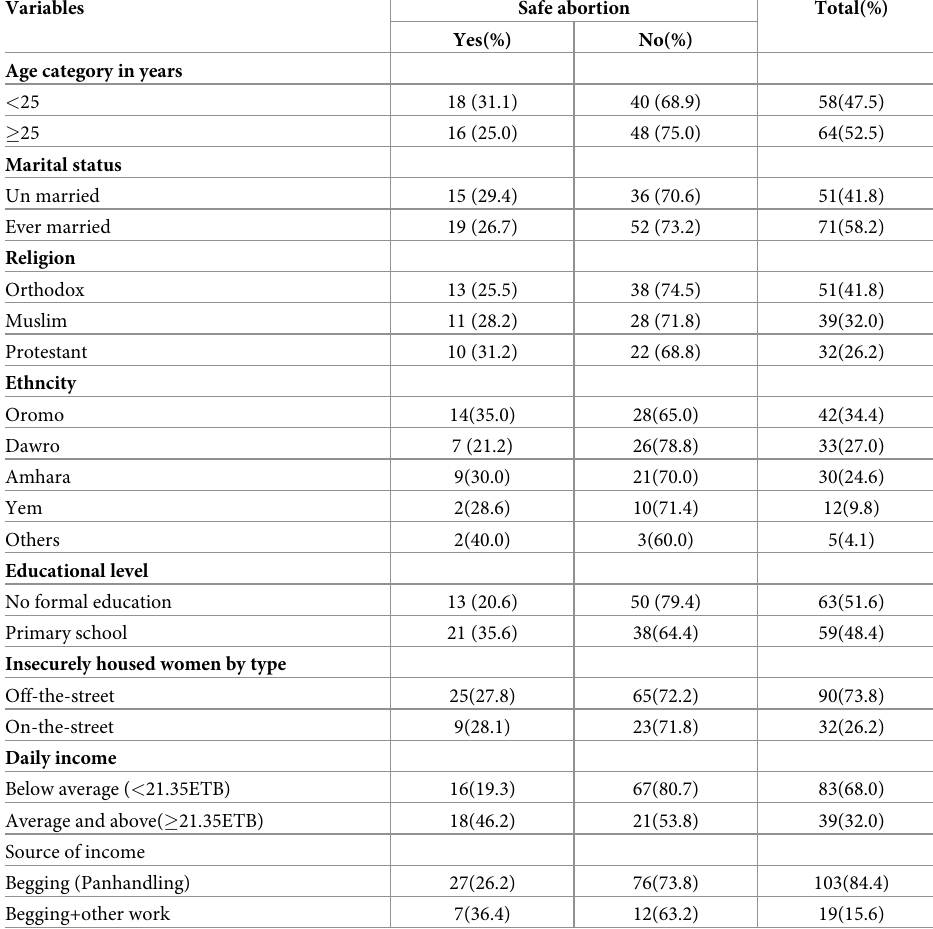
Table 1. Socio-demographic information of insecurely housed women in southwest Ethiopia,